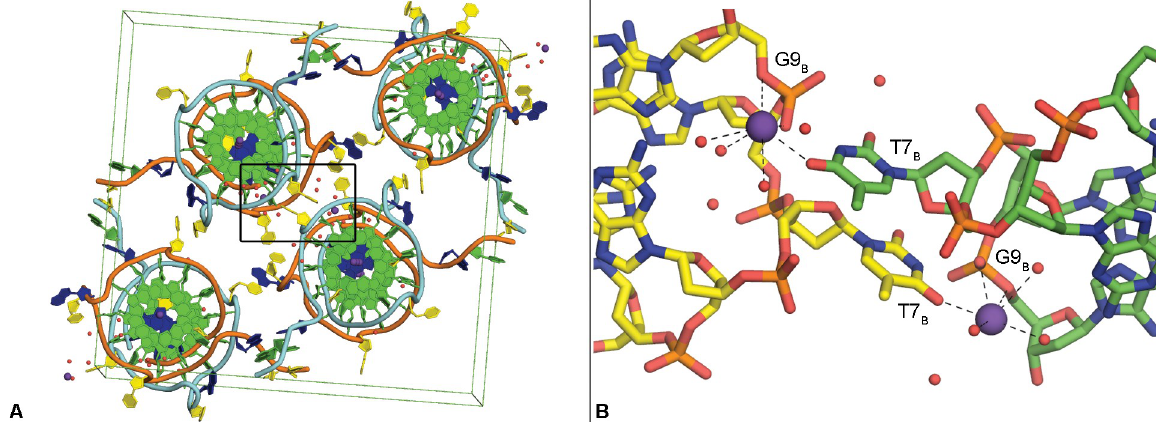
Fig 3. Crystal packing and non-channel potassium ions. Packing arrangement in the unit cell of c-MYC promoter quadruplex crystal structure formed by Pu22, coloring scheme same as Fig 2; black box indicates region shown in Fig 3B (A). Non-channel potassium ions interact with residues T7 and G9 (B).